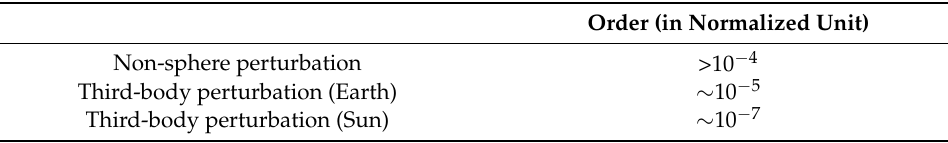
Figure 1. The relative position vectors are illustrated in the figure. r ab means the relative position vector pointing from a to b . Table 1. The order of several kinds of